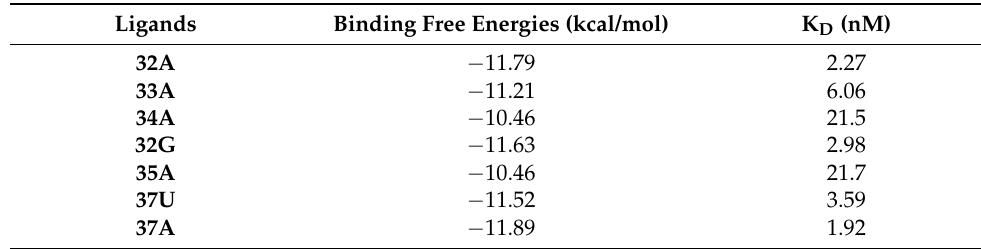
Table 5. The binding free energies (kcal/mol) and predicted K D values (nM) between the 50S ribosomal subunit (PDB ID: 1YHQ) and the ligands.